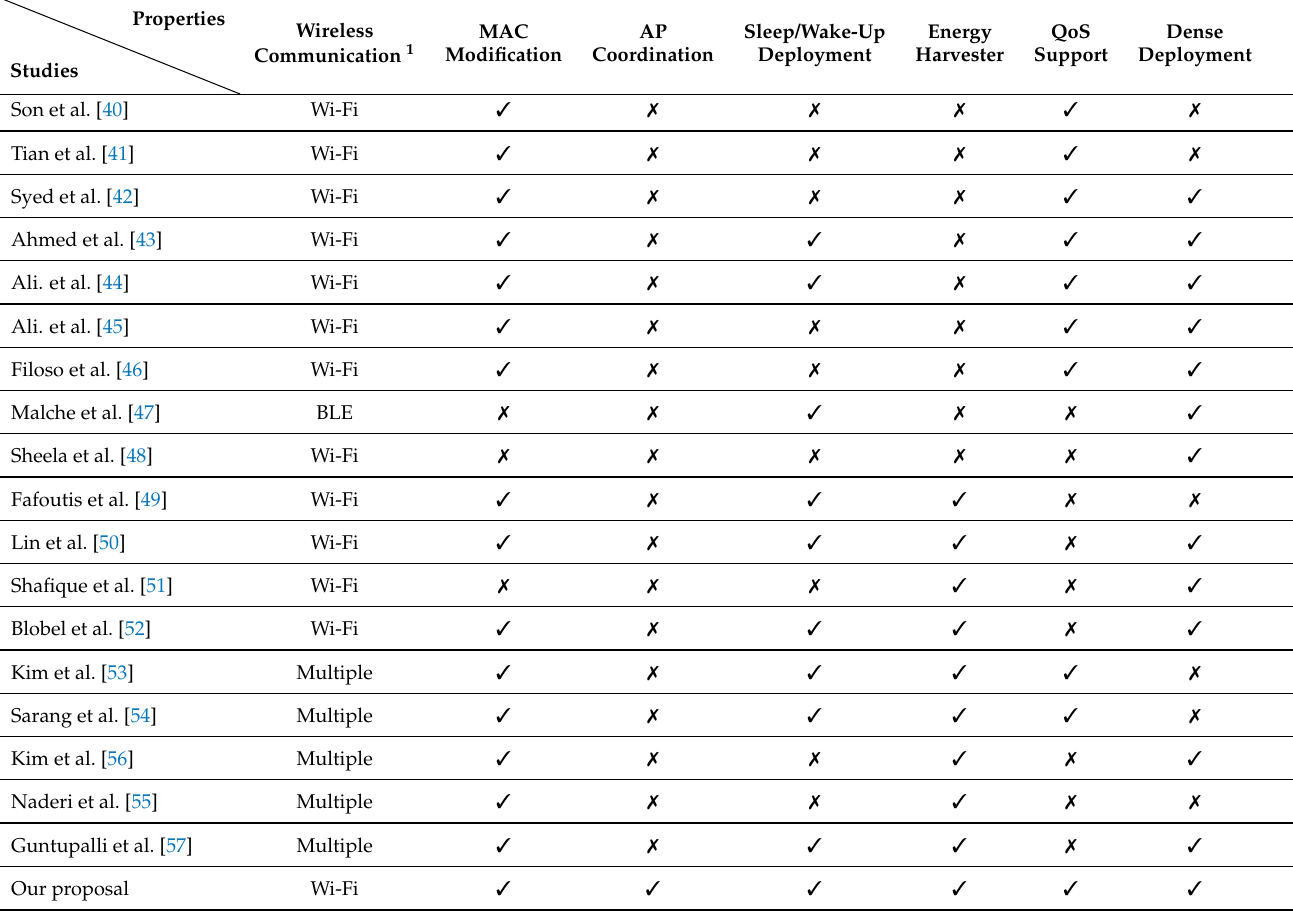
Table 3. Features comparison of related work and our